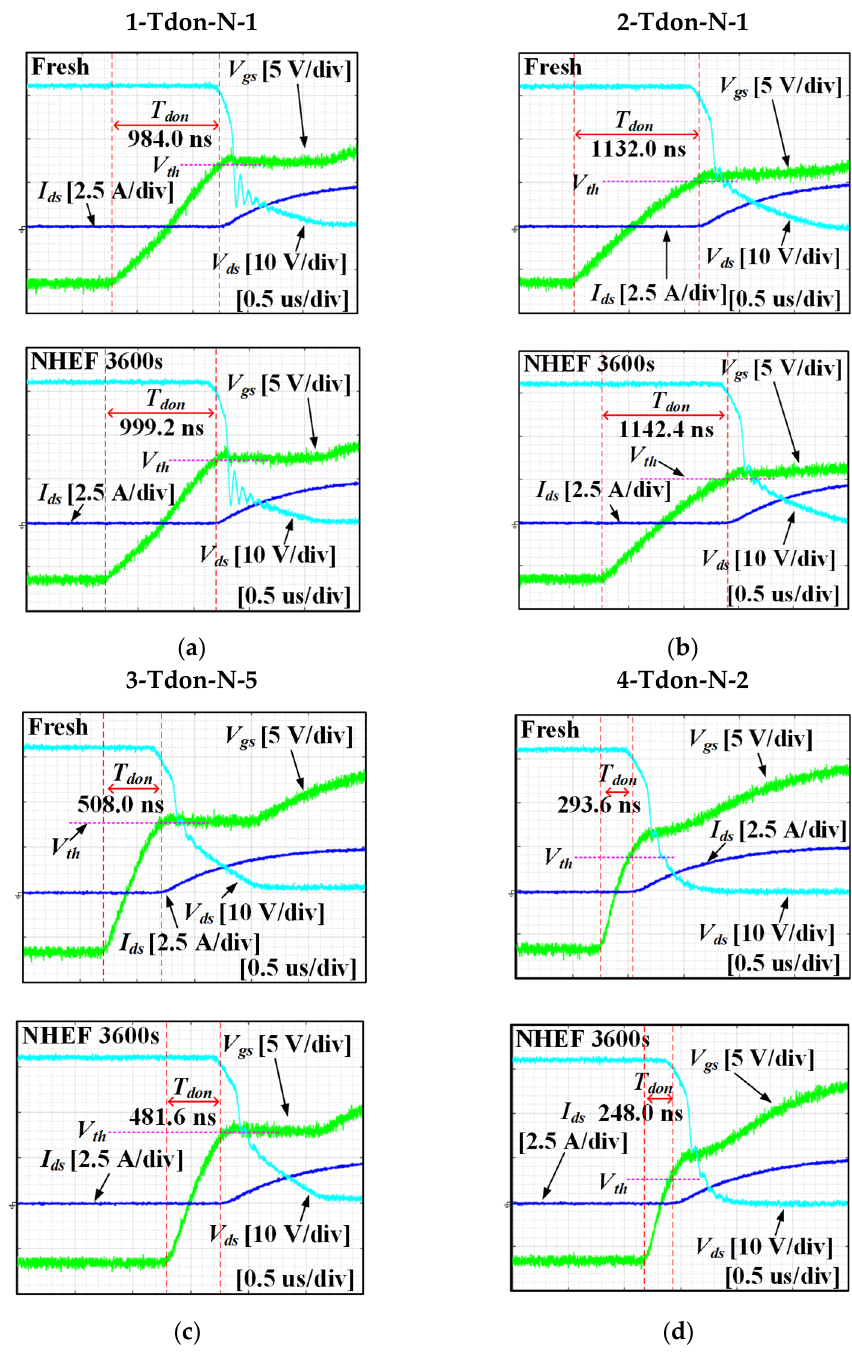
Figure 13. T don variations in PHEF stress: ( a ) Si IGBT, ( b ) Si MOSFET, ( c ) Si IGBT with SiC diode, and ( d ) SiC MOSFET.